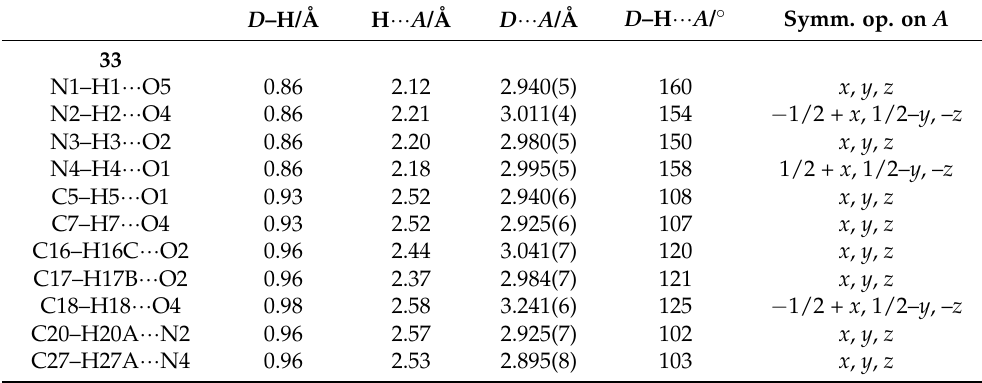
Figure 9. Conformations of L -Val peptide 33 (left) and D -Val peptide 36 (right) with intramolecular hydrogen bonds shown as cyan dashed lines. Table 1. Geometric parameters of hydrogen bonding in compound 33 (Å , °).